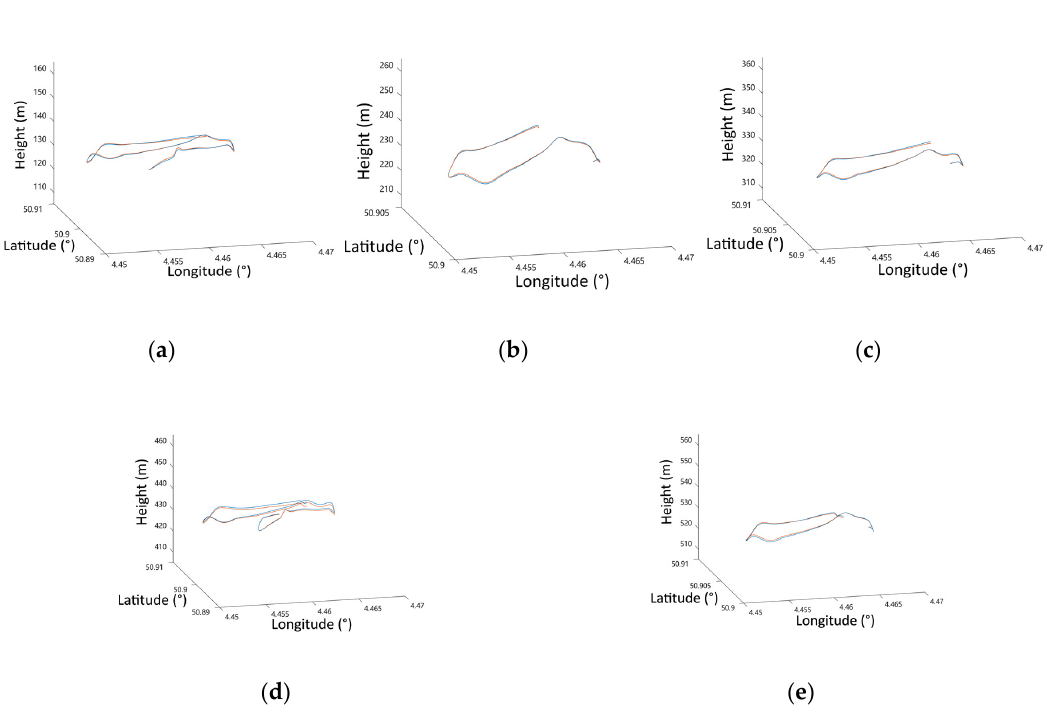
Table 2. The aircraft positioning